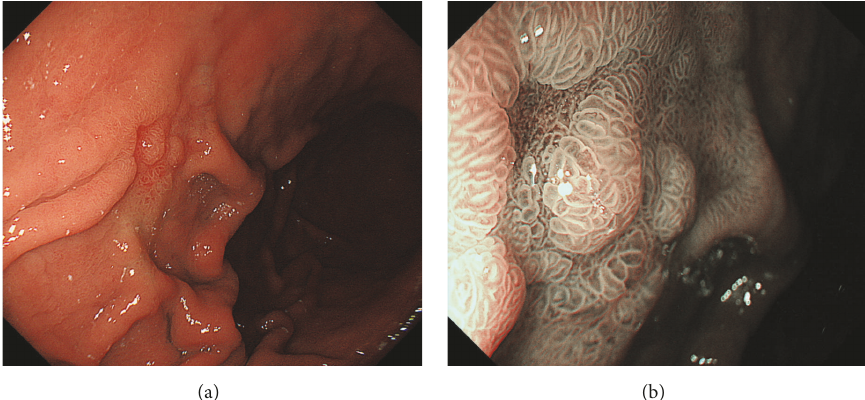
Figure 5: Esophagogastroduodenoscopy images after treatment. Three months after successful eradication of H. pylori , the whitish lesions disappeared.